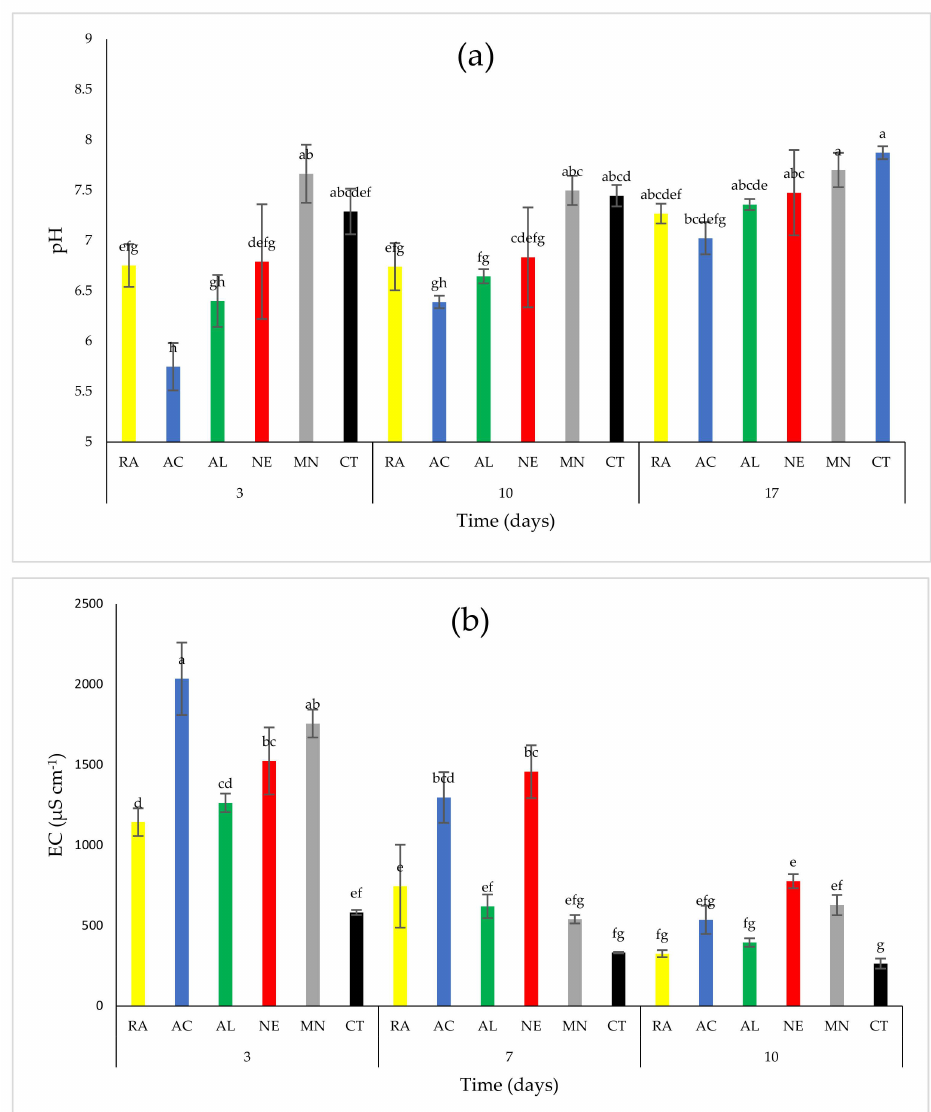
Figure 1. Effect of fertilizer treatment (RA = Raw dairy slurry; AC = Acidified dairy slurry; AL = Alkalinized dairy slurry; NE = Neutralized dairy slurry; MN = Mineral fertilizer; CT: Control) and time after fertilizer application (3, 10, and 17 days) on the EC ( a ) and pH ( b ) values measured in leachates. Two-way ANOVA indicated a positive interaction of both parameters. Mean values ( n = 4) with different letters indicate significant differences based on the Tukey test ( p < 0.05). Error bars represent standard errors of 4